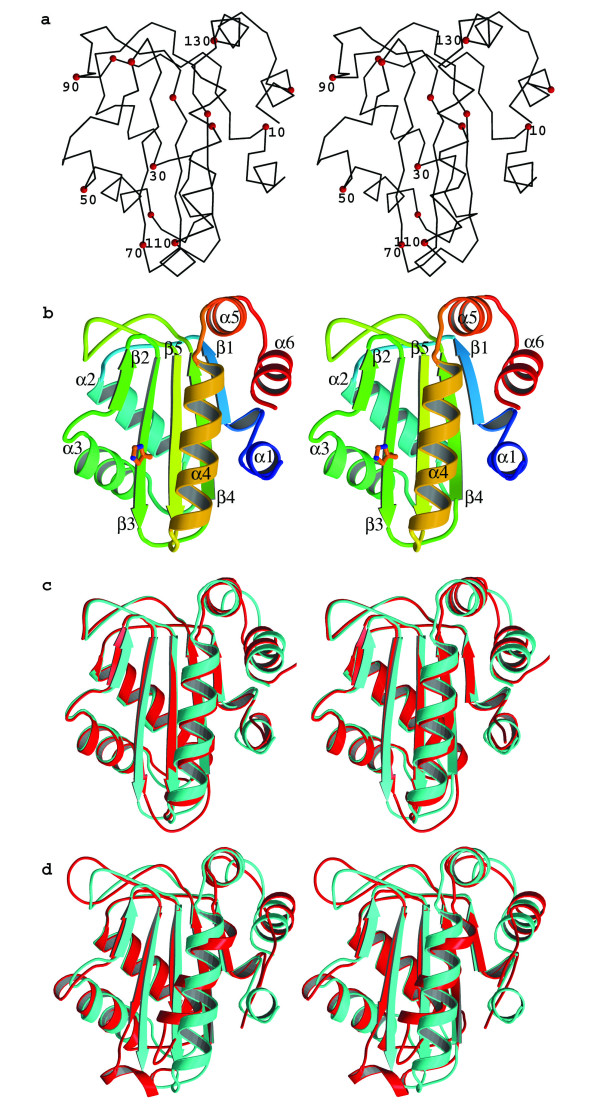
Structure of NM-IIAntr. (a) Stereo figure of a Cα-trace of NM-IIANtr with every twentieth residue numbered (b) Stereo figure of a ribbon diagram of NM-IIANtr with secondary structure elements labelled (α-helices 1–4; β-strands 1–5). The active site residue H67 is displayed as ball-and-stick. (c) Stereo figure of an overlay of NM-IIANtr (green) and E. coliIIANtr (red) (d) Stereo figure of an overlay of NM-IIANtr(green) and E. coli IIAmtl(red).